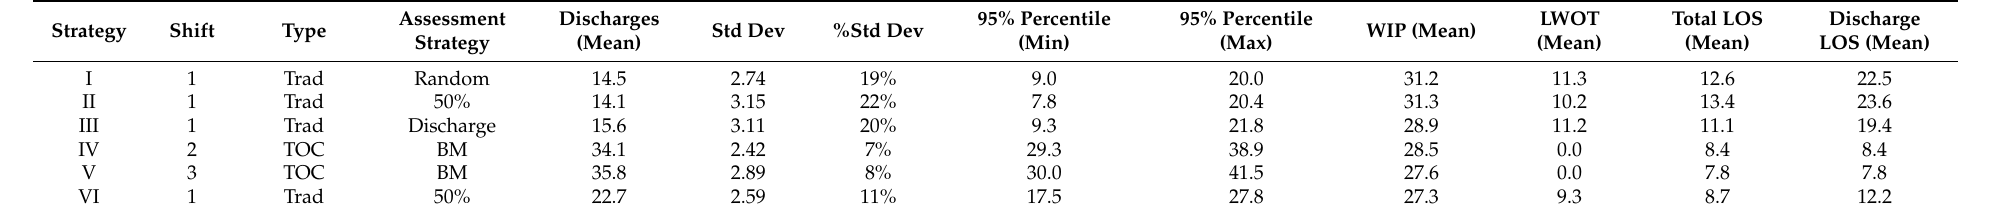
Table 1. Monte Carlo (MC) simulation results for the six strategies with their respective statistical analysis after 10,000 runs. Strategies I, II, and III represent variations of the traditional management philosophy with different priorities utilized for MEDICAL ASSESSMENT. Strategy IV represents the TOC approach of applying the first three steps of the 5FS and Buffer Management. Strategy V is similar to Strategy IV but includes step 4 “Elevate”. Strategy VI represents the traditional management approach after adding a new resource (die) at MEDICAL ASSESSMENT to improve the ED performance (as in Strategy